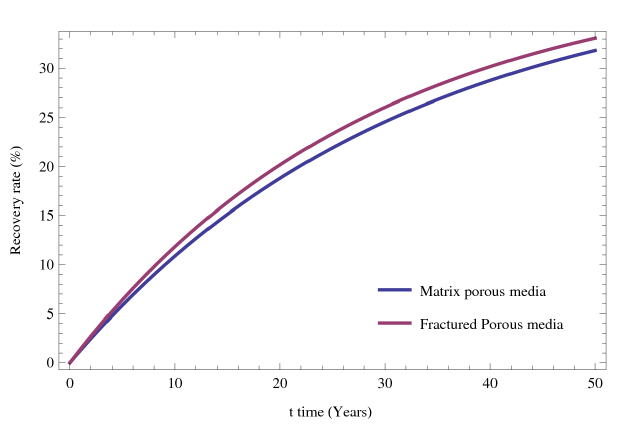
Fig. 9: Comparison of recovery rate in fractured and matrix porous medium